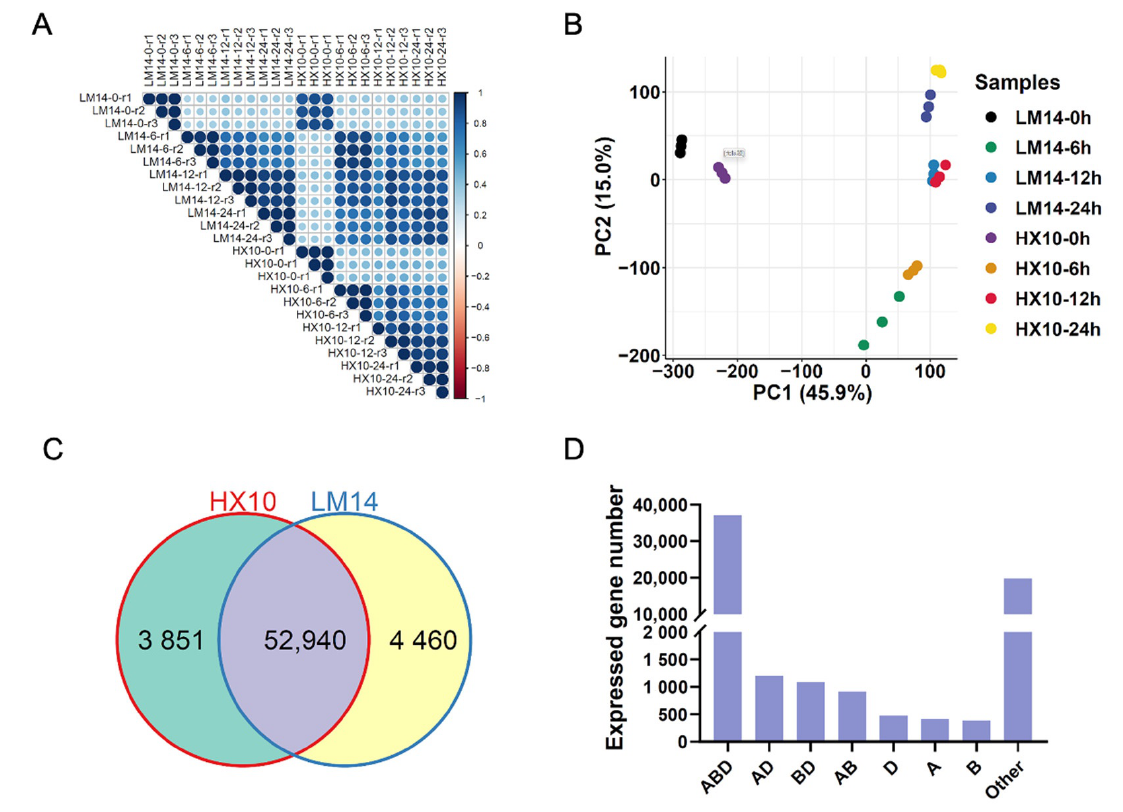
Figure 3. Identification of expressed genes using RNA-sequencing. ( A ) The hierarchical structure of Pearson correlation coefficient analysis. The colors from dark red to dark blue represent − 1.0 to 1.0 of the Pearson correlation coefficients. ( B ) Principal component analysis (PCA) of different RNA-seq samples. Pearson correlation coefficient analysis and PCA were performed based on the gene expression of genes with more than 1 TPM. ( C ) Expressed gene numbers of HX10 and LM14 shown in the Venn diagram. ( D ) Expressed gene numbers in ABD subgenomes of wheat. The column above ABD refers to the number of genes expressed in all three subgenomes, the column above AD refers to the number of genes expressed only in A and D subgenomes (but not expressed in the B subgenome), and the column above A refers to the number of genes expressed only in A subgenome (but not expressed in B or D subgenome).